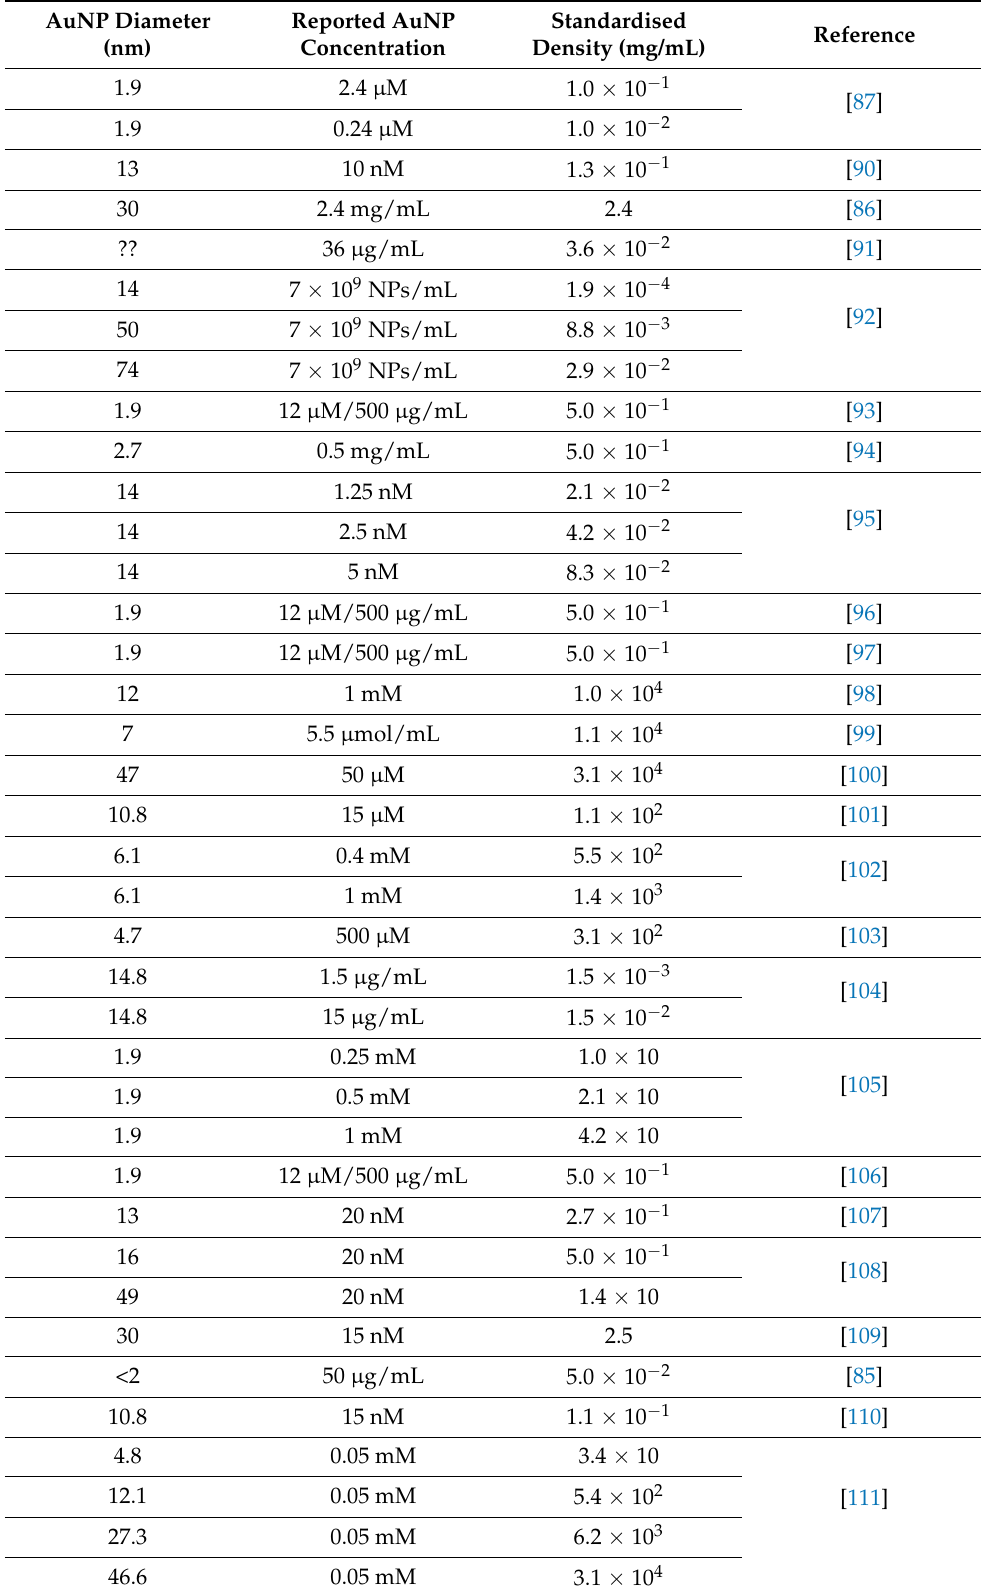
Table 1. A summary of AuNP-mediated RDEE studies in the literature. AuNP concentrations reported are given, as well as the calculated: imaging density.” Table adapted with permission from ref. [32]. Copyright 2021 The Institute of Cancer